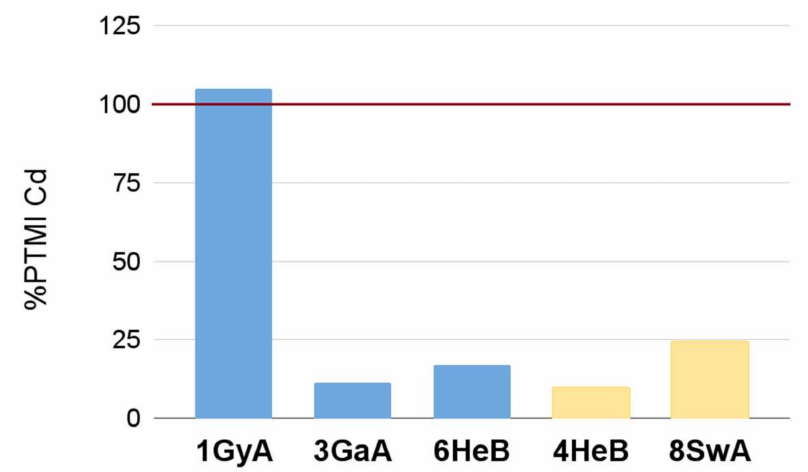
Figure 3. The ratio of EMI to PTMI values for the chosen dietary supplements (taking into account consumption of the recommended dosage/month by an average adult weighing 70 kg). The blue bars are for capsule supplements and the yellow bars are for